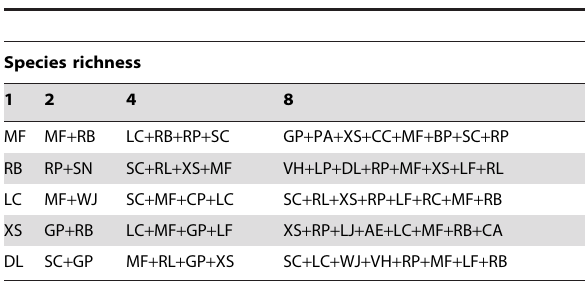
Table 1. The species composition of each plot at the four different species richness levels for the natural communities growing on the Huangyan Pb/Zn mine tailings.